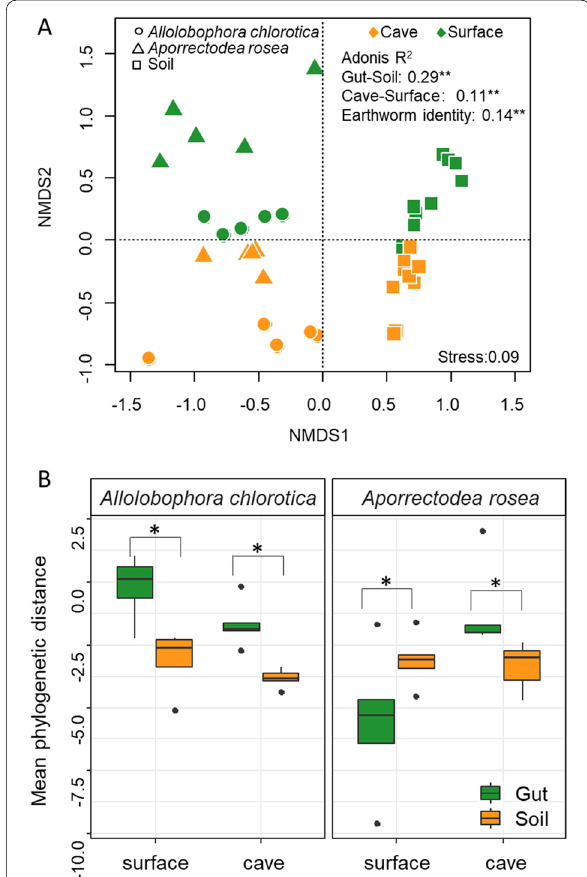
Fig. 3 Ordination plot of microbiota ( A ) and the standardized effect size of mean phylogenetic distance of bacterial communities ( B ) in the soil and gut of earthworms present in caves and the